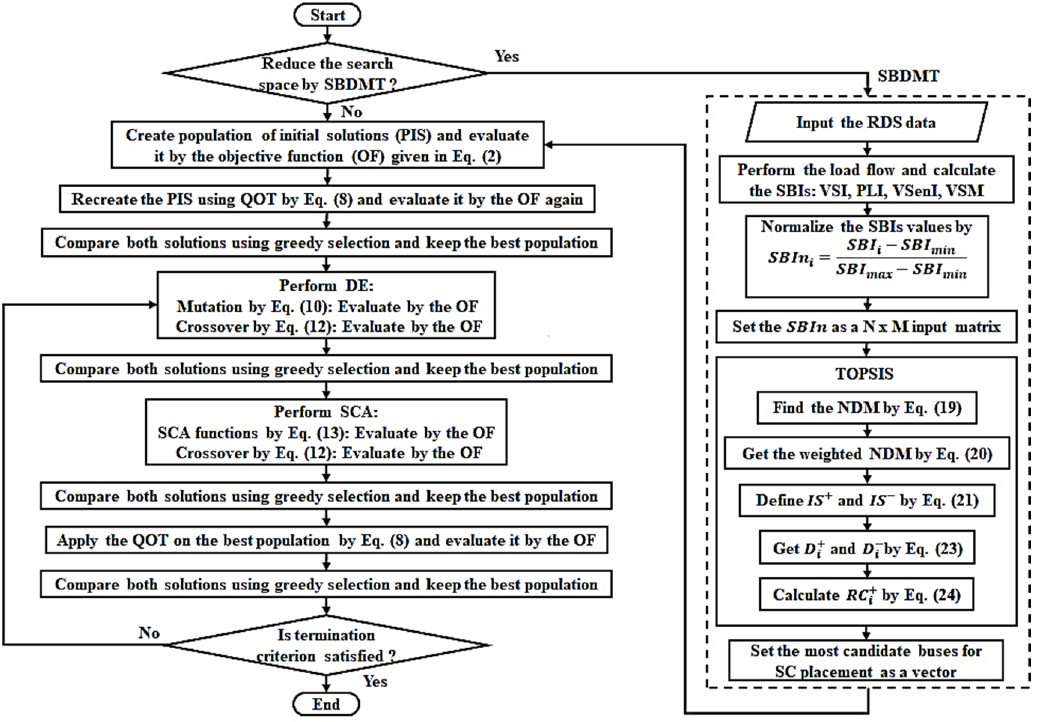
Figure 2. Flowchart of the proposed permutated oppositional differential evolution sine cosine algorithm (PODESCA) and sensitivity-based decision-making technique (SBDMT).